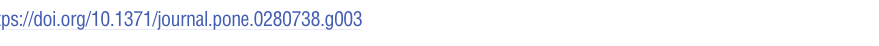
Fig 3. Plot for the interaction between client involvement and team bonding capital on individual member idea